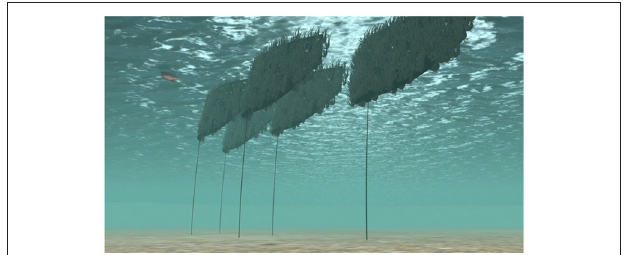
FIGURE 2 | A patented 2D sheet, developed by Seaweed Energy Solutions for seaweed cultivation in exposed waters (image from www.theexplorer.no/solutions/industrial-scale-offshore-seaweed-cultivation/). Image reproduced with permission.